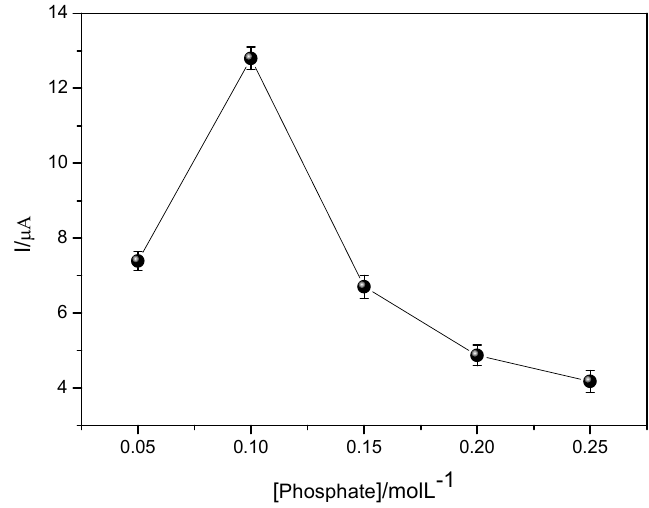
Figure 14. Influence of phosphate buffer concentration pH 7.0 on current variation (ΔI). Solution 175 μmol L −1 of Ethinyl estradiol.